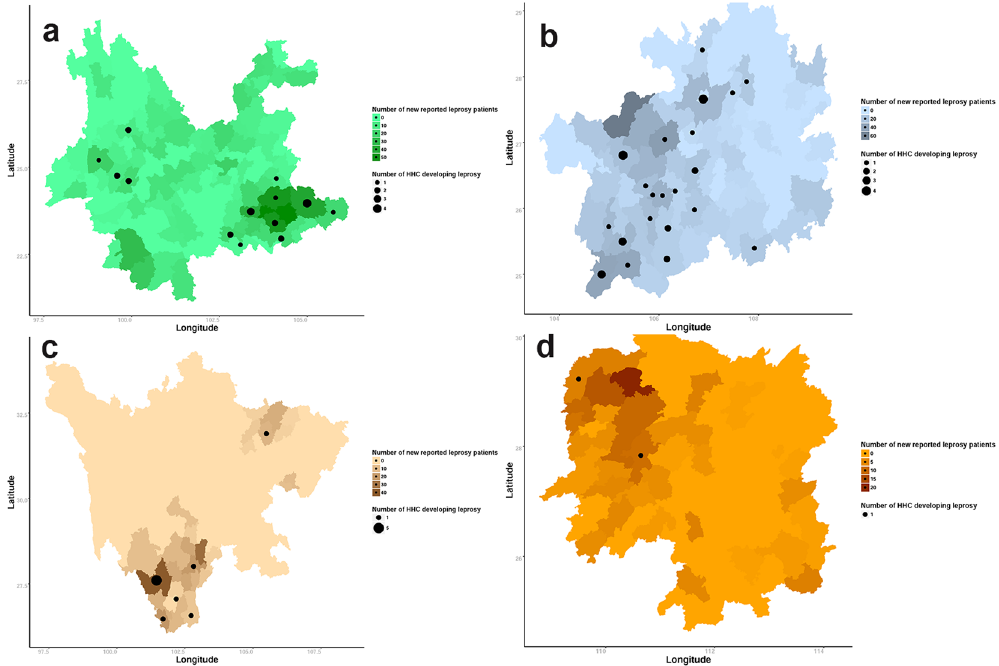
highlighted with different colors to represent the number of new leprosy cases reported among these four provinces. The depths of colour represent the number of new leprosy patients. The location of each patient recorded, and HHC that developed leprosy, in the monitoring period in ( a ) Yunnan, ( b ) Guizhou, ( c ) Sichuan and ( d ) Hunan provinces are depicted by black dots, with the size of each dot representing the number of HHC that developed leprosy. The maps in this figure were generated by means of software R, including maptools, maps and mapdata (Version 3.3.3, https://cran.r-project.org/src/base/R-3/).